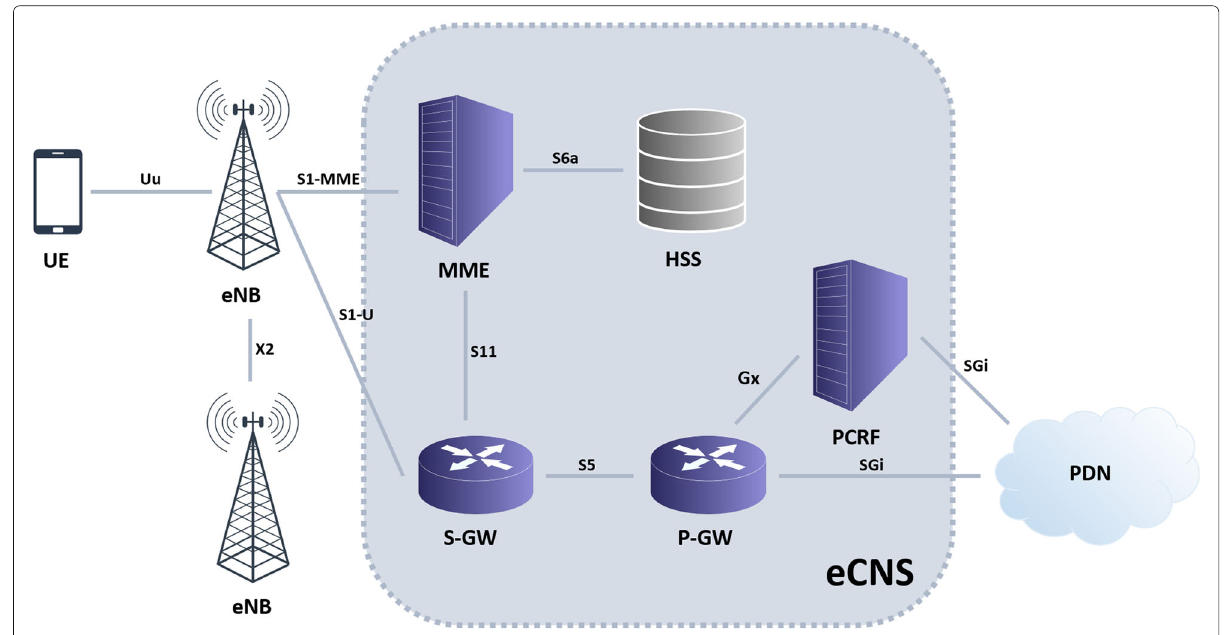
Fig. 4 UMAHetNet general